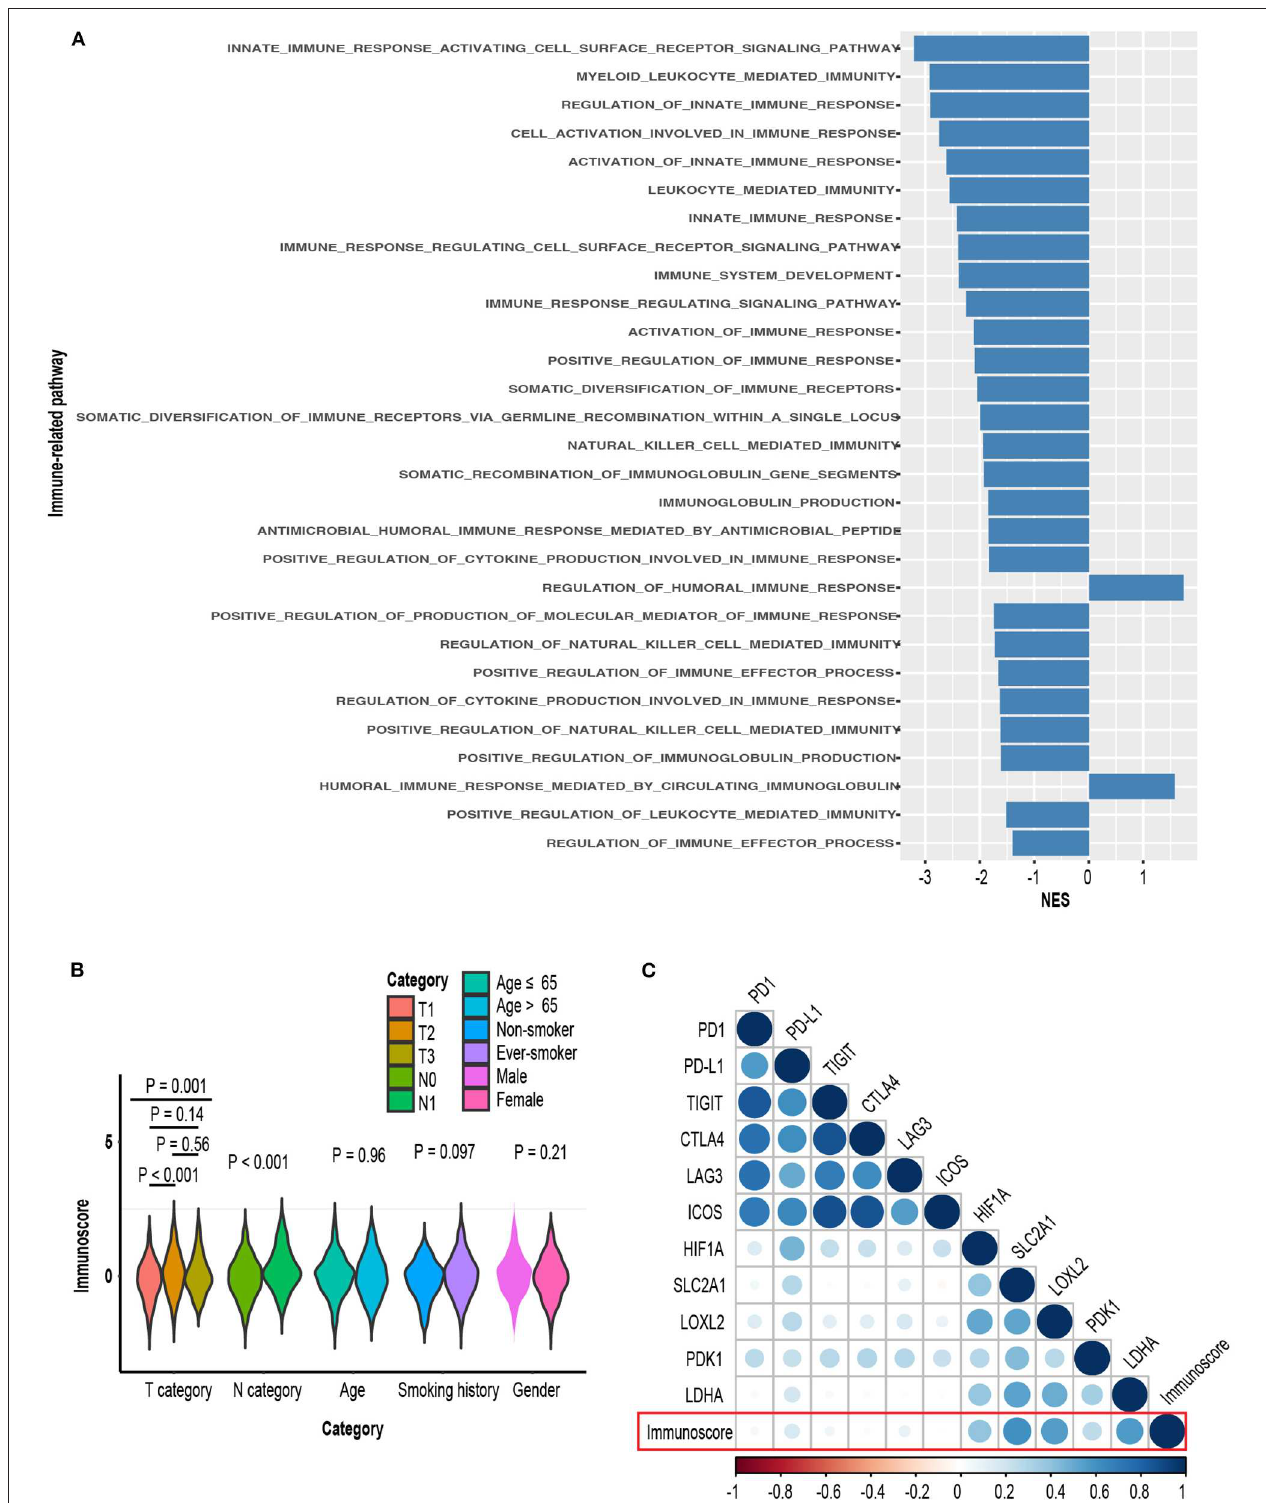
FIGURE 11 | (A) Comparison of enrichment levels of immune-related pathways between high-immunoscore and low-immunoscore subgroups. (B) Distribution of immunoscore in various clinical subgroups. (C) Correlation matrix of immunoscore and certain gene expression.